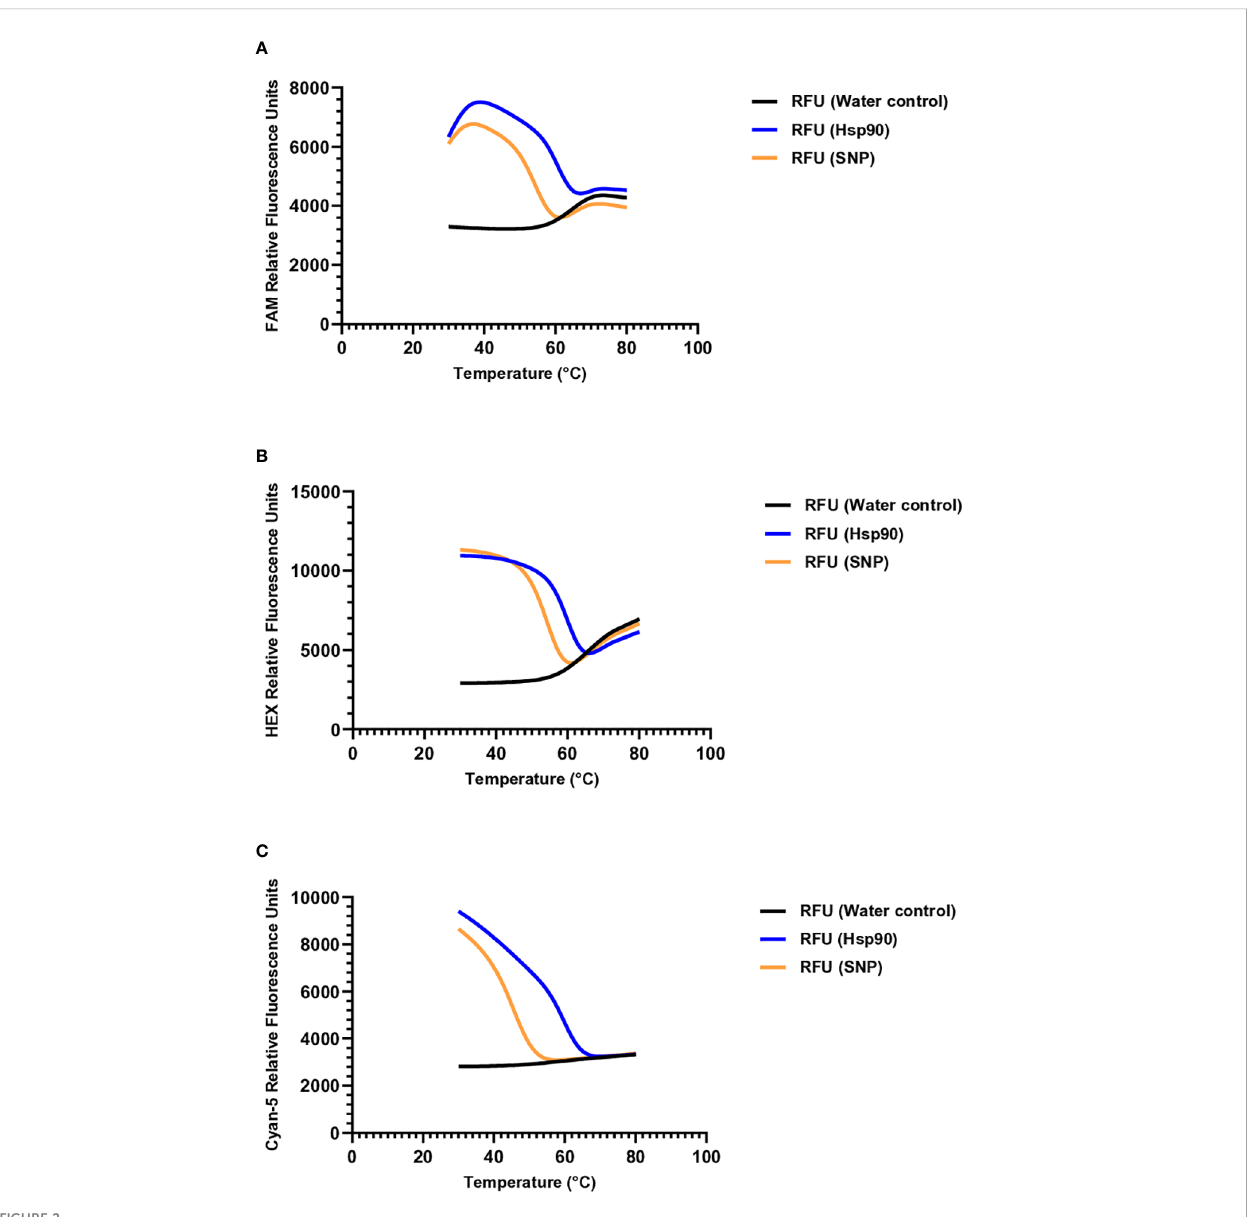
FIGURE 2 Denaturation curves of molecular beacon probes (A) M. chitwoodi beacon C1-Hsp90- FAM-6 in the presence of excess complementary template, SNP template, or no template (B) M. fallax beacon F1-Hsp90-HEX-5 in the presence of excess complementary template, SNP template, or no template. (C) M. minor beacon M2-Hsp90-Cyan-5 in the presence of excess complementary template, SNP template, or no